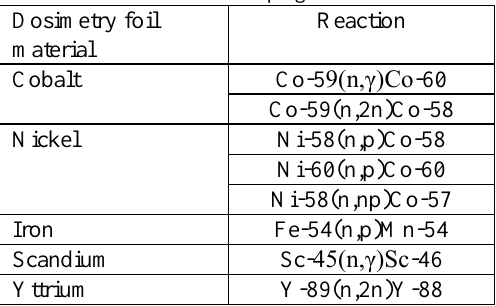
Studied reactions in the dosimetry foils from LTIS in the C38 deuterium campaign at JET.